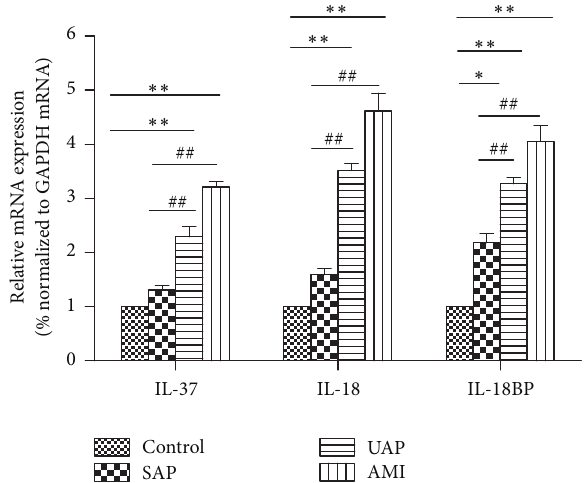
Figure 2: The expression of IL-37, IL-18, and IL-18BP in PBMCs was markedly higher in the AMI and UAP groups than those in the control group, and the expression of IL-18BP in the SAP group was higher than that in the control group. ∗ 𝑃 < 0.05 versus Control, ∗∗ 𝑃 < 0.01 versus Control, ## 𝑃 < 0.01 versus SAP.